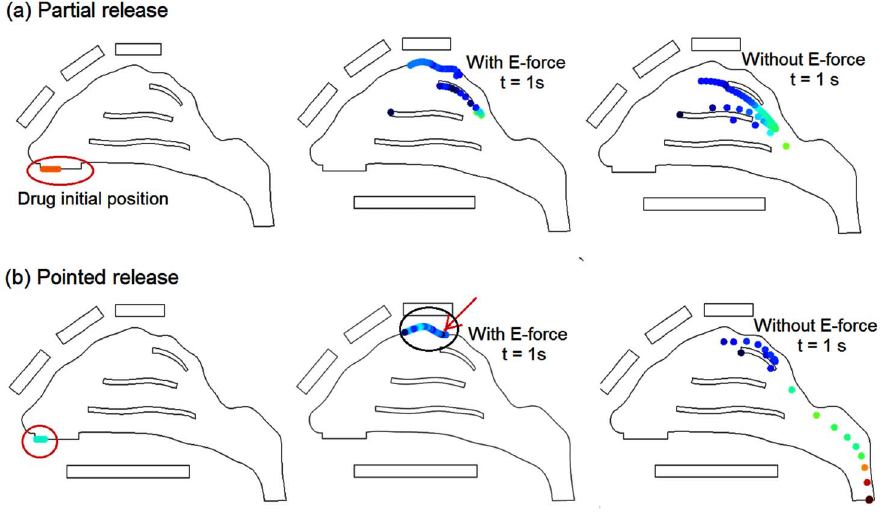
Figure 4. Particle trajectories with and without electric forces: (a) partial release; (b) pointed release.